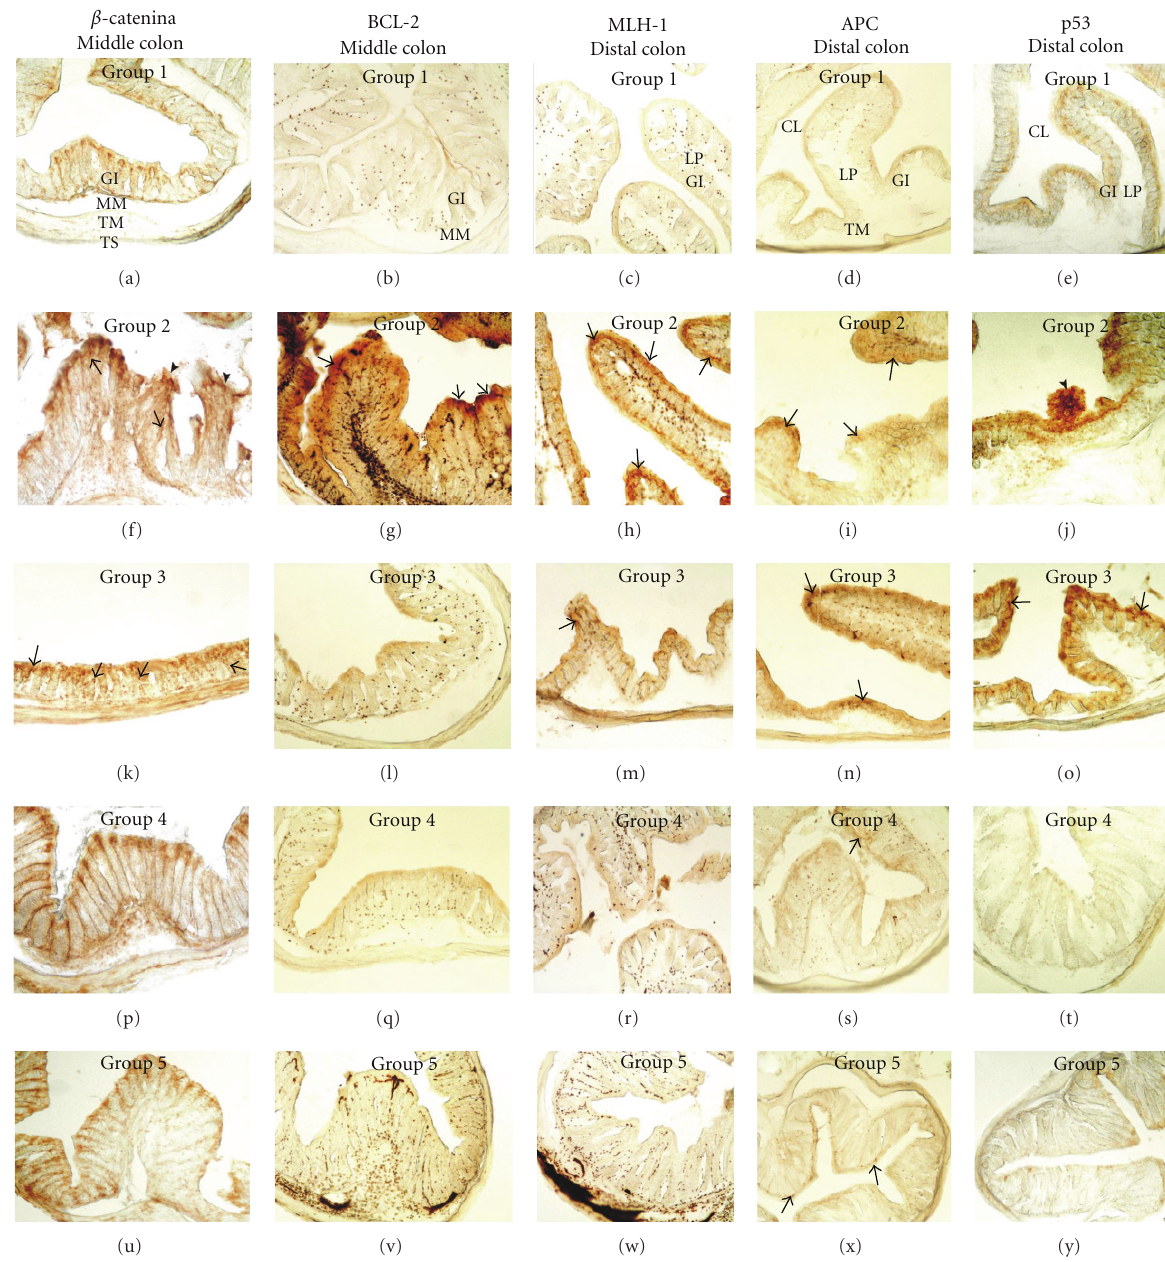
Figure 3: Immunohistochemistry of colorectal pathological markers in di ff erent transverse section of colon in mice. (a – e) Details of transverse sections at middle and distal colorectal levels of mice group 1, showing scarce immunoreactivity to Catenin- β , p53 or absence of BCL-2, MLH-1, and APC. Note that these sections also show a normal epithelial organization with well-di ff erentiated cryptal cells. (f – j) Details of transverse colon sections of mice group 2, showing intense immunoreactivity to the cell markers studied. Note the numerous immunoreactive cells (arrows in (f–i)) and their massive location at the di ff erent pathological lesions, such as severe-grade dysplasia (arrowheads in (f)), polyps (arrowhead in (j)), and adenomas. (k – o) Details of transverse colon sections of mice group 3, showing moderate- to-scarce immunoreactivity to the cell markers in the colorectal segments. Note some immunoreactive cells to Catenin- β (arrowheads in (k)), MLH-1 (arrow in (m)), APC (arrows in (n)), and p53 (arrows in (o)). (p – t) and (u–y). Details of transverse colon sections of mice group 4 (p–t) and goup 5 (u–y), showing absence or basal (arrows in (s) and (x)) immunoreactivity to the cell markers in the colorectal segments studied. Scale bar: 100 μ